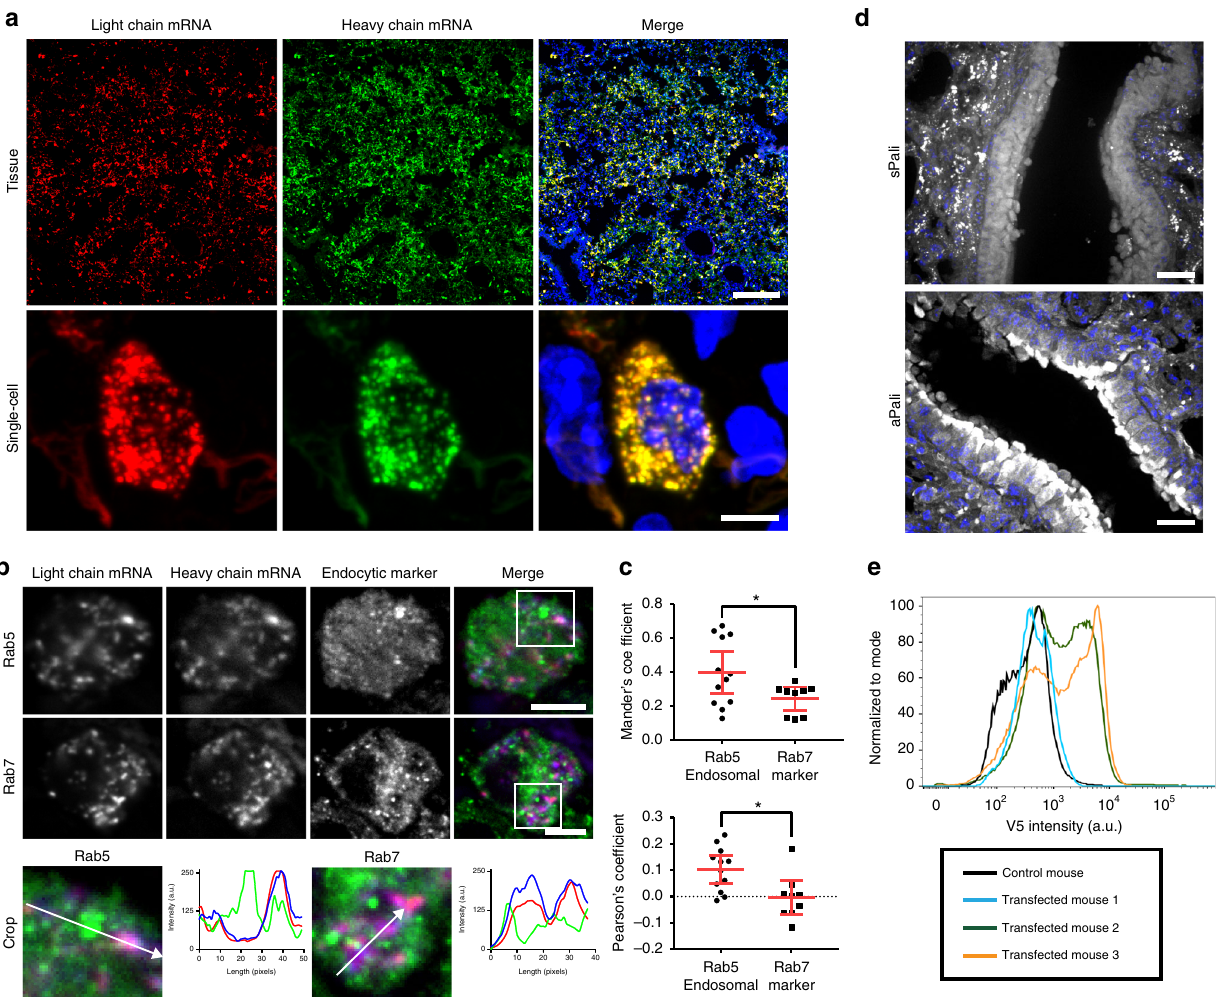
Fig. 3 Distribution of aPali mRNAs and expression in lung epithelia. a Cy3B labeled light chain (red) and DyLight 650 labeled heavy chain (green) mRNA was transfected into the lungs of mice. At 4 h, lungs were sectioned and imaged on a whole tissue (top) or single cell basis (bottom). Scale bar represents either 200 μ m (top) or 5 μ m (bottom). b Tissue sections from part ( a ) were stained for Rab5 or Rab7 (green) for early or late endosomes, respectively. Scale bar represents 5 μ m. Cropped regions are magni fi cations of white boxes in whole cell images with intensity pro fi les along the direction of the white arrow. c Mander ’ s colocalization coef fi cient and Pearson ’ s correlation between light chain mRNA and Rab5 or Rab7. Dotted line indicates 0 correlation. n ≥ 10 cells per group. Error bars represent 95% con fi dence interval. Asterisk indicates p < 0.05 by two-tailed t -test. d Mice lungs were transfected with either sPali (top) or aPali (bottom) mRNA using Viromer Red. At 4 h, tissue sections were stained for the expressed antibody (white). Scale bar represents 25 μ m ( n = 2 mice per group). e Mice lungs were transfected with aPali heavy chain and V5 tagged light chain mRNA. Flow cytometry was performed on dissociated lungs stained for V5. Histograms of V5 intensity were normalized to the mode of